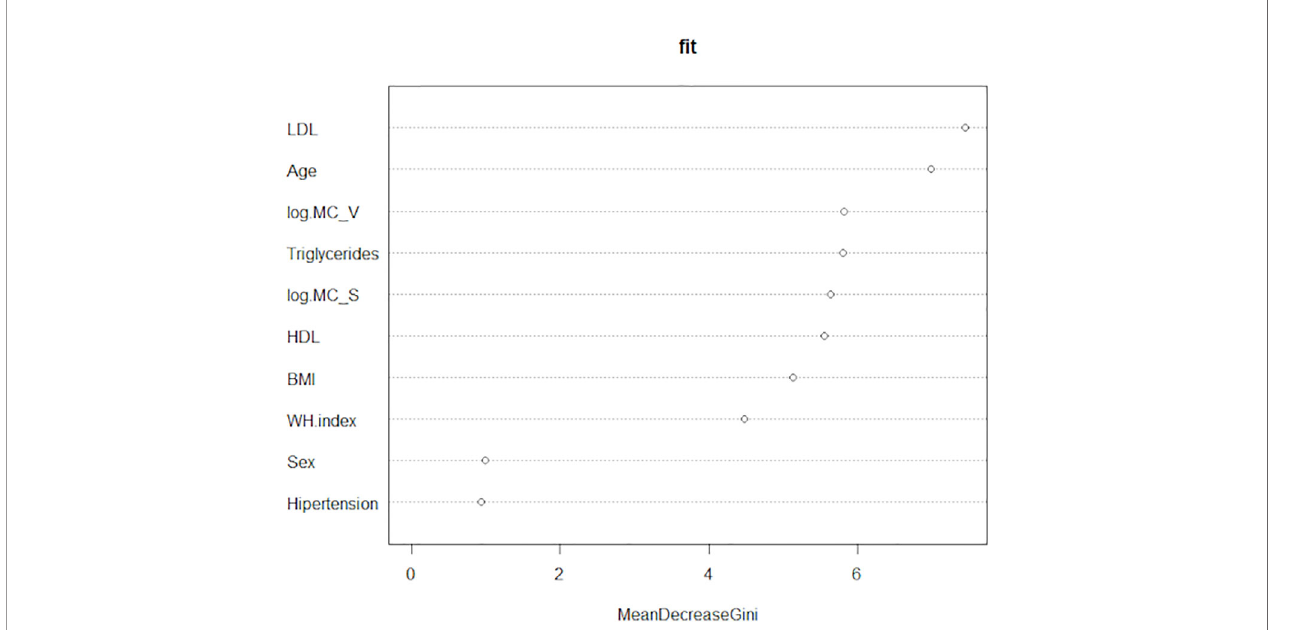
FIGURE 9 | Random Forests Analysis. This technique measures the importance of the variables to discriminate the three levels of the categorical variable “ Type 2 diabetes ” . The data comes from the big cohort (n = 100). MC_V (mast cells in omental white adipose tissue), MC_S (mast cells in subcutaneous white adipose tissue), WH index (waist-hip